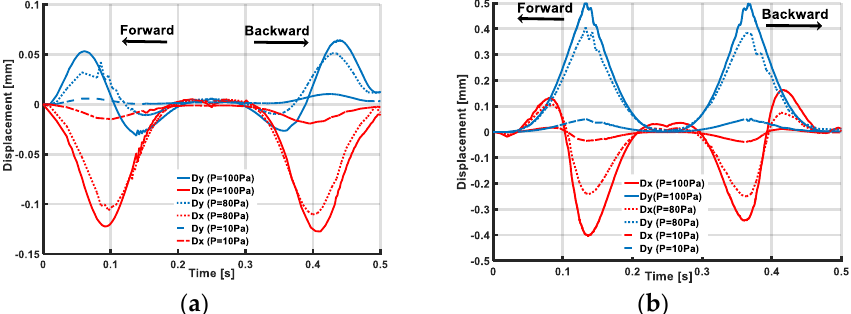
Figure 6. Simulation results show displacements 𝐷𝑦, 𝐷𝑥 under various pressurizations: ( a ) X-sliding and ( b ) Y-sliding.